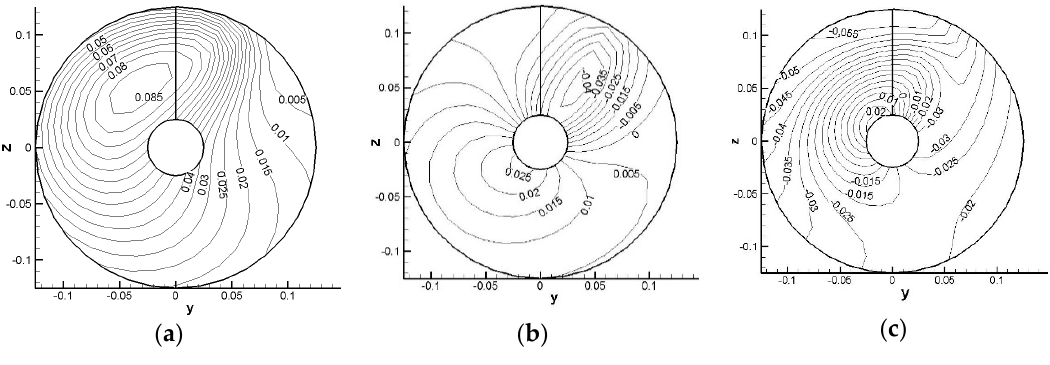
Figure 5. Induced velocity in tight front of the propeller. ( a ) Axial-induced velocity; ( b ) Circumferential-induced velocity; ( c ) Radial-induced velocity.